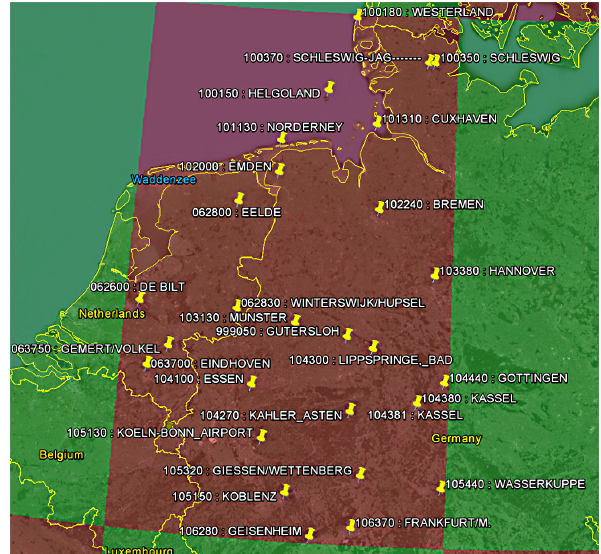
Figure 4. Image from Google Earth showing the CRUTEM4 weather station locations within a particular grid box (the yellow marker pins). The CRUTEM4 identifier number (ID) and name of each weather station is shown with white text next to each yellow marker pin. The ID is usually the WMO ID, made up of two or three digits to represent the country and the remaining digits to represent the station (in this example, the stations beginning with 06 are in the Netherlands, and with 10 are in Germany). If the station has not been allocated a WMO ID, or is from a source that has not used the WMO ID system, then it usually begins with 99 (e.g. 999050 Gutersloh in this example).